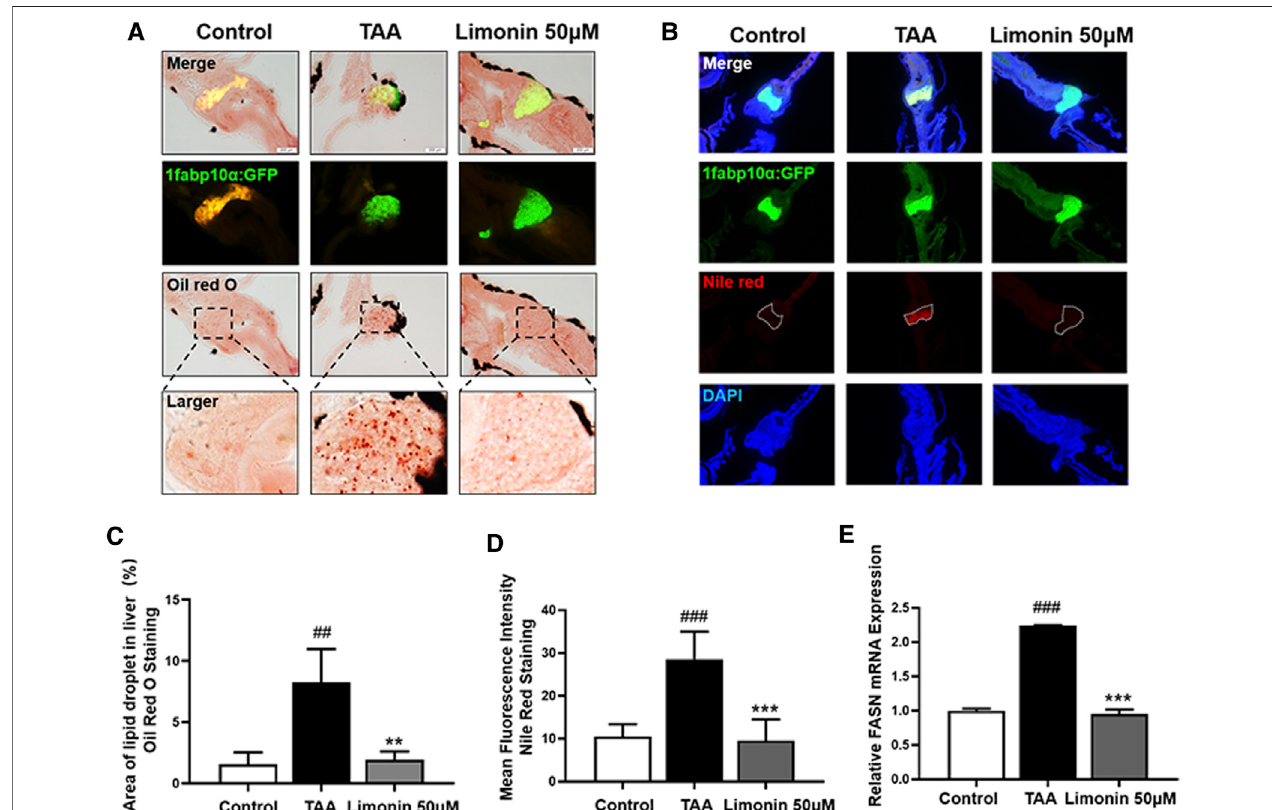
FIGURE4| LimoninreducedlipidaccumulationcausedbyTAAinzebra fi shliver. (A) OilredOstainingoffrozensectionsofzebra fi shlarvae. (B) Frozenliversections of zebra fi sh larvae with liver-speci fi c eGFP expression were stained with Nile Red. Figures are magni fi ed as × 200. (C) Quantitative analysis of the area of lipid droplet in liver based on Oil Red O staining. (D) Quantitative analysis of the liver mean fl uorescence intensity of Nile Red. (E) Real-time PCR analysis of FASN mRNA levels in zebra fi shlarvae.The mRNA levels were normalized to β -actin mRNAlevels and presented asfoldchangecompared with thecontrolgroup. Dataareshown asthe mean ± SD ( n (cid:1) 6 – 8 per group). # p < 0.05, ## p < 0.01, ### p < 0.001 vs control group; * p < 0.05, ** p < 0.01, *** p < 0.001 vs TAA